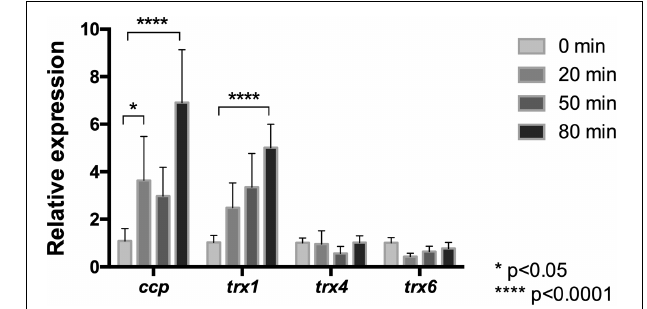
FIGURE 6 | Antioxidant protein activity in L. ferriphilum DSM 14647. The cytochrome c peroxidase (A) and thioredoxin activity (B) in cells exposed to 100 mM NaCl. The data represent the average of three independent experiments (bar indicates the value range). Statistical analysis was carried out by ANOVA Test.